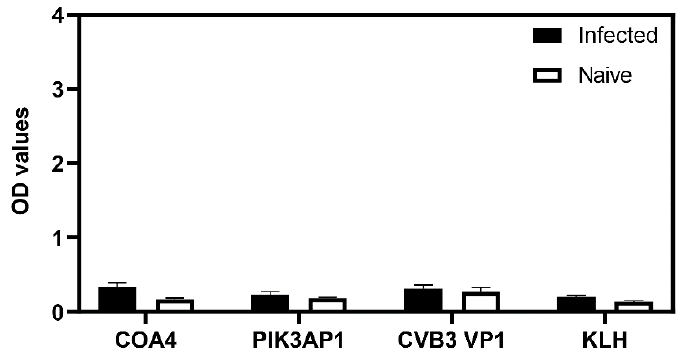
Figure 6. Infection with influenza virus does not lead to the production of antibodies to COA4 or PIK3AP1. BALB/c mice were infected with or without mouse-adapted influenza A virus (A/Puerto Rico/8/34 (NR-28652)). Sera collected at termination on day 21 post-infection were diluted (1:100) and tested for their reactivity to COA4, PIK3AP1, CVB3 VP1, or KLH. After adding HRP-conjugated anti-mouse total Ig and substrate, reactions were stopped to measure the OD values at 450 nm. Mean ± SEM values represent three samples in each group. Two-way ANOVA with Sidak’s test was used to determine significance between groups.